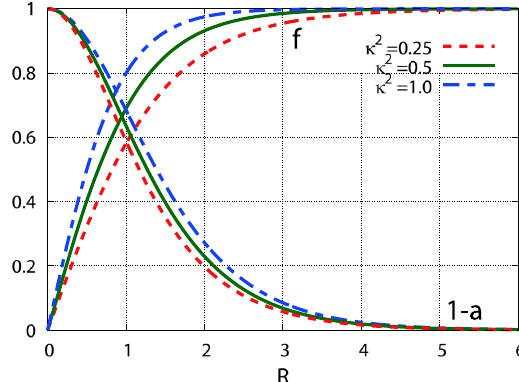
, 1 √ , and 1, with a unit winding 2 2